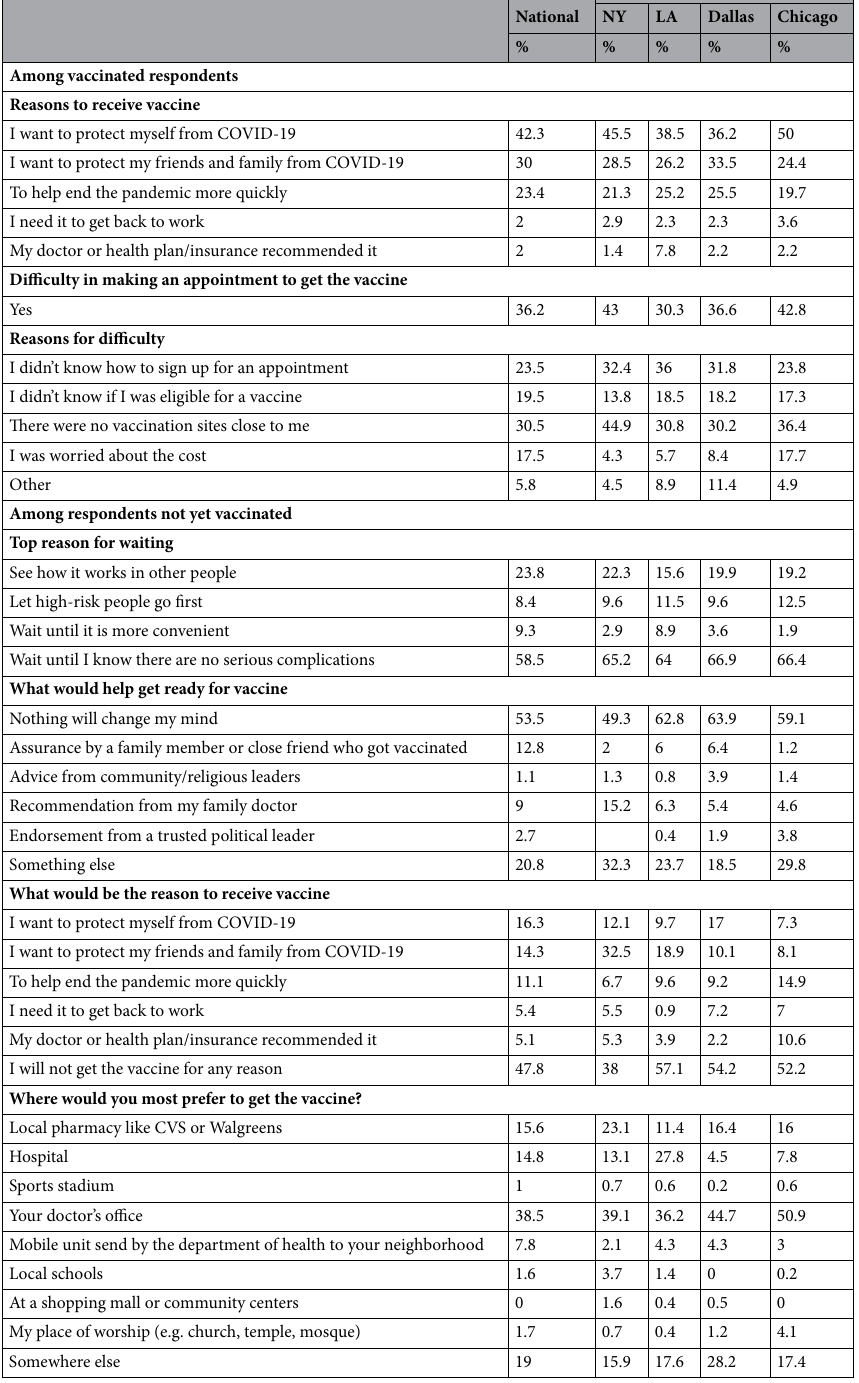
Table 2. Vaccination reasons. % are weighted to the geographic